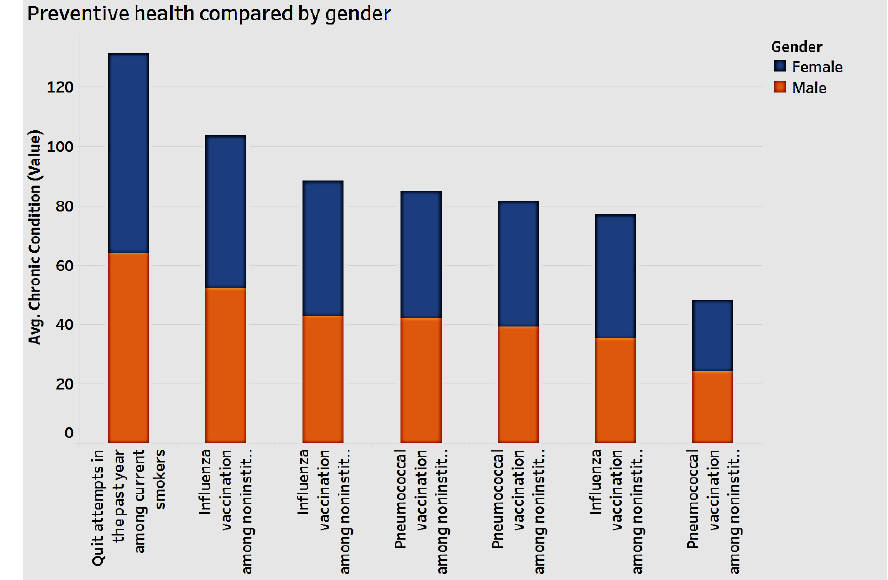
Figure 12. Preventive health by gender.